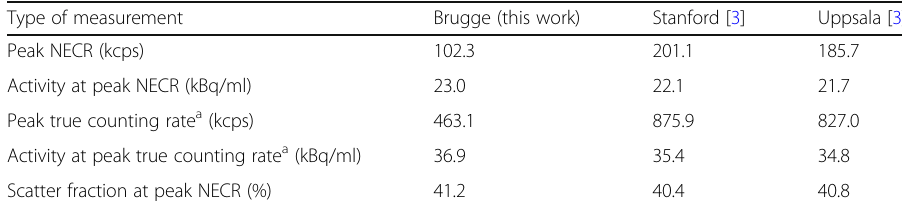
Table 2 Counting rate data Type of